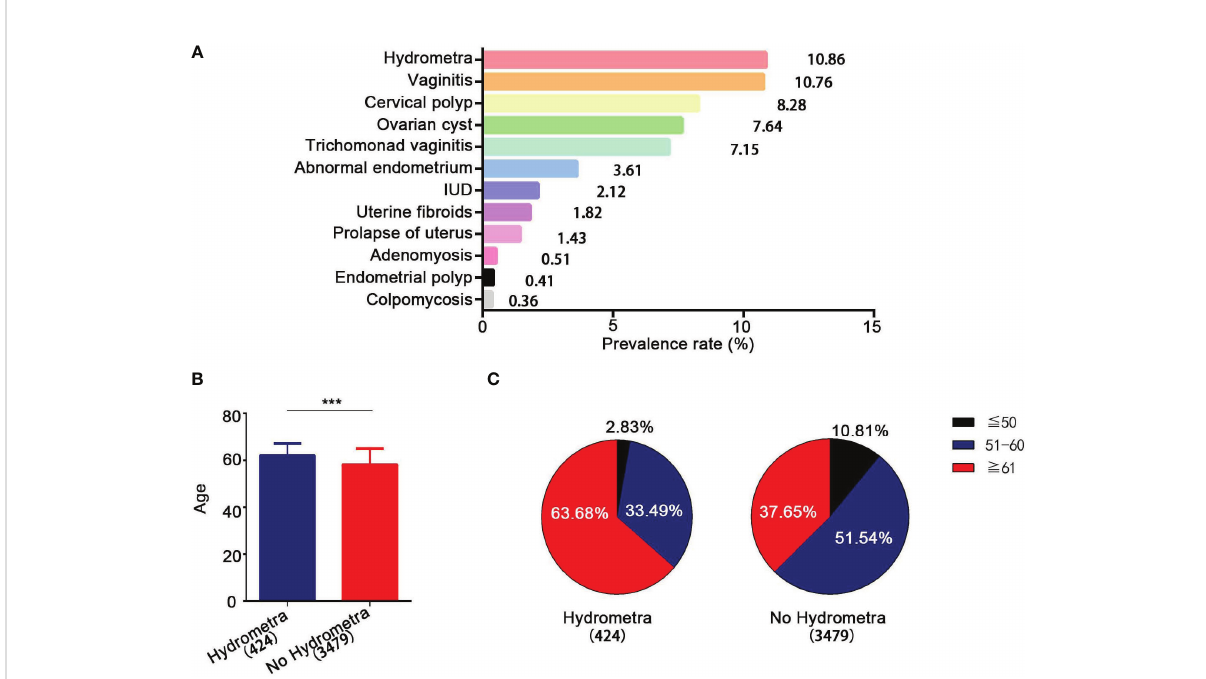
FIGURE 1 Epidemiological analysis of hydrometra. (A) Prevalence rate of different gynecological diseases. The y -axis represents different gynecological diseases, and the x -axis represents prevalence rate. (B) Age comparison between women with and without hydrometra. (C) Age distribution comparison between women with hydrometra and without hydrometra. *** p